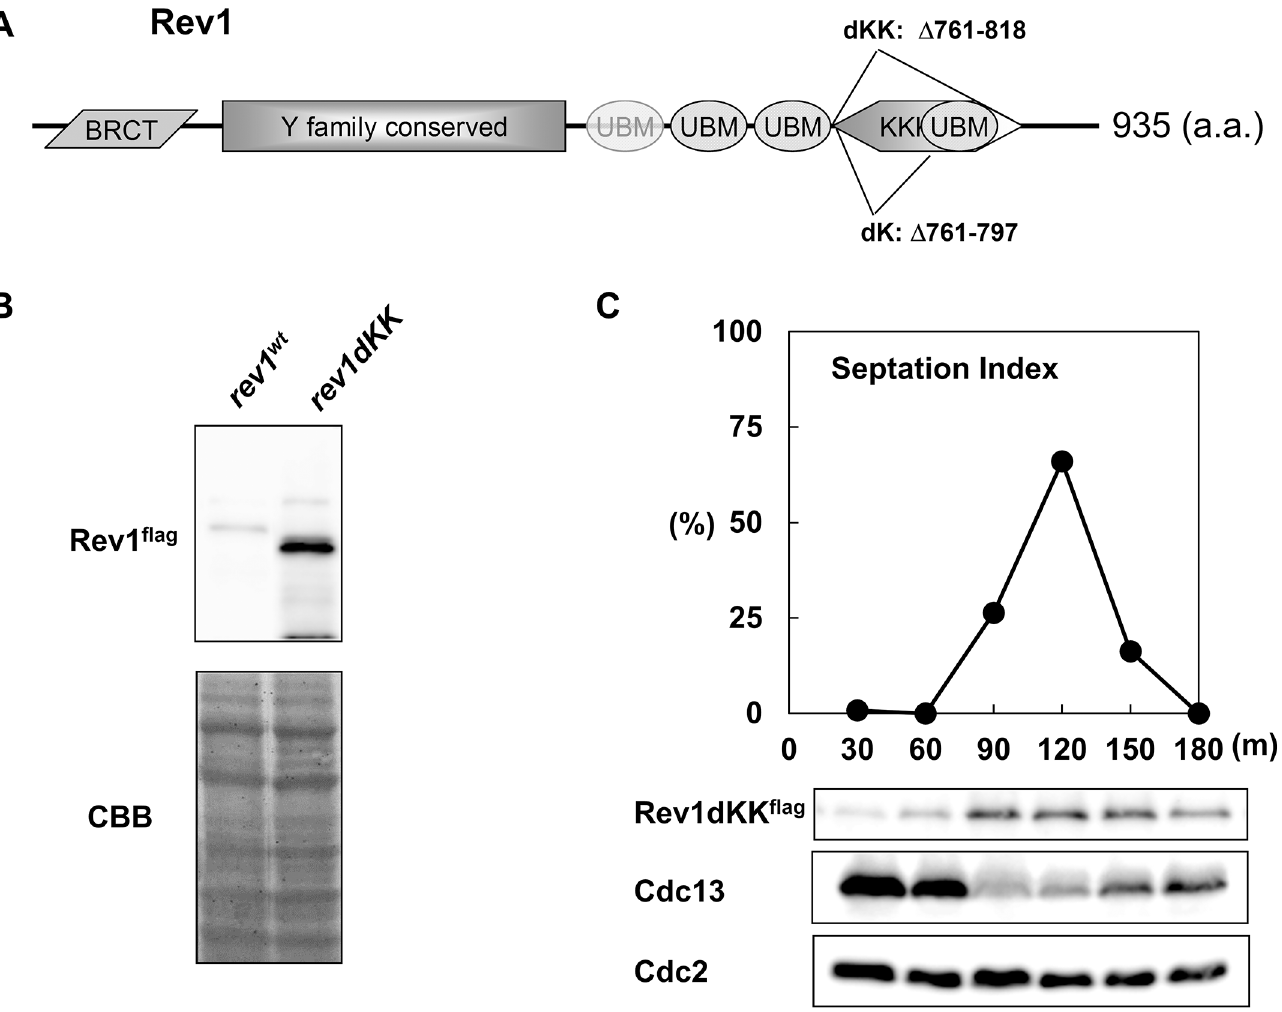
Fig 2. An internal deletion mutant stabilized Rev1 protein in the S phase. A, Schematic diagram of the fission yeast Rev1 domain structure. Parallelogram, BRCT; rectangle, Y family-conserved region; ellipse, ubiquitin binding motif; hexagon, Lys-rich region. Rev1dK and Rev1dKK are internal deletion mutants lacking the amino acids from 761 to 818 and 761 to 797, respectively. B, The Rev1dKK mutant stabilized Rev1 protein. Flag-tagged rev1 wt and rev1dKK cells were grown, and whole cell extracts were prepared by the boiling method. The upper panel shows a western blot of Rev1 protein, and the lower panel shows CBB staining of the membrane as a loading control. The left lane represents Rev1 wt , and the right lane represents Rev1dKK. C, Rev1dKK protein was stable in S phase. Time course samples of the rev1dKK flag cdc25 strain were prepared. The samples were taken every 30 min after the release. The lower panels show the expression patterns of Rev1dKK, Cdc13, and